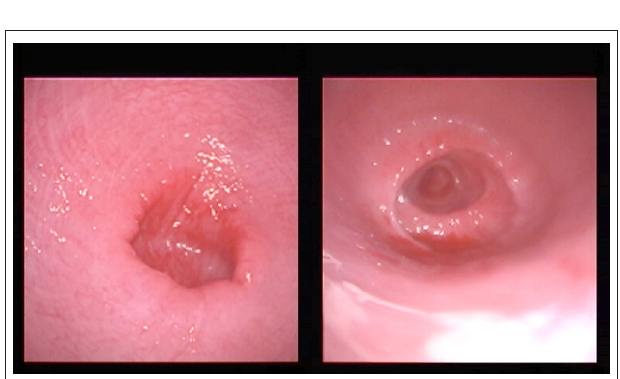
FIGURE 2 | Typical appearance of the cervix by vaginoscopy from two females. The cervix is open and lacks tone.